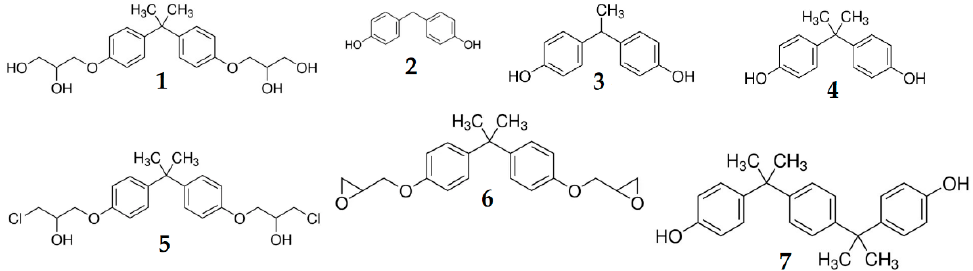
Figure 3. Chemical structures of all studied analytes. 1—BADGE · 2H 2 O, 2—BPF, 3—BPE, 4—BPA, 5—BADGE · 2Hl, 6—BADGE, 7—BPP.